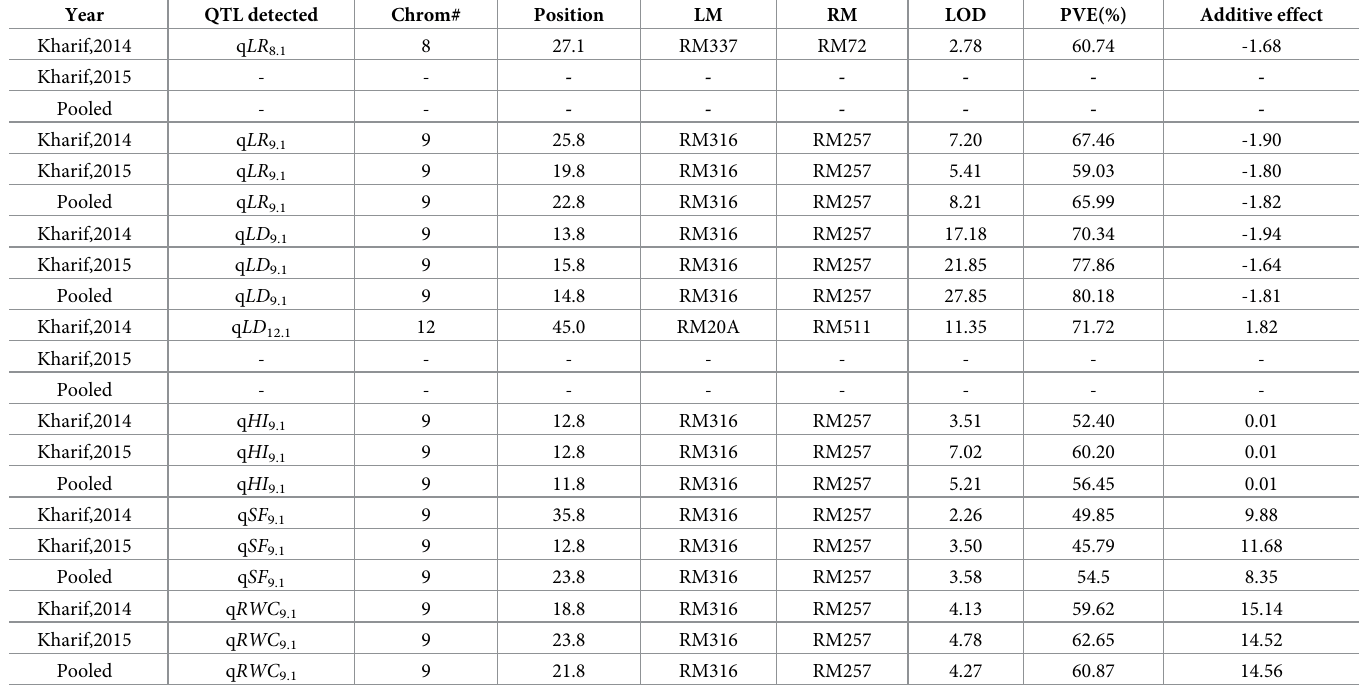
Table 6. QTLs detected by linkage analysis using inclusive composite interval